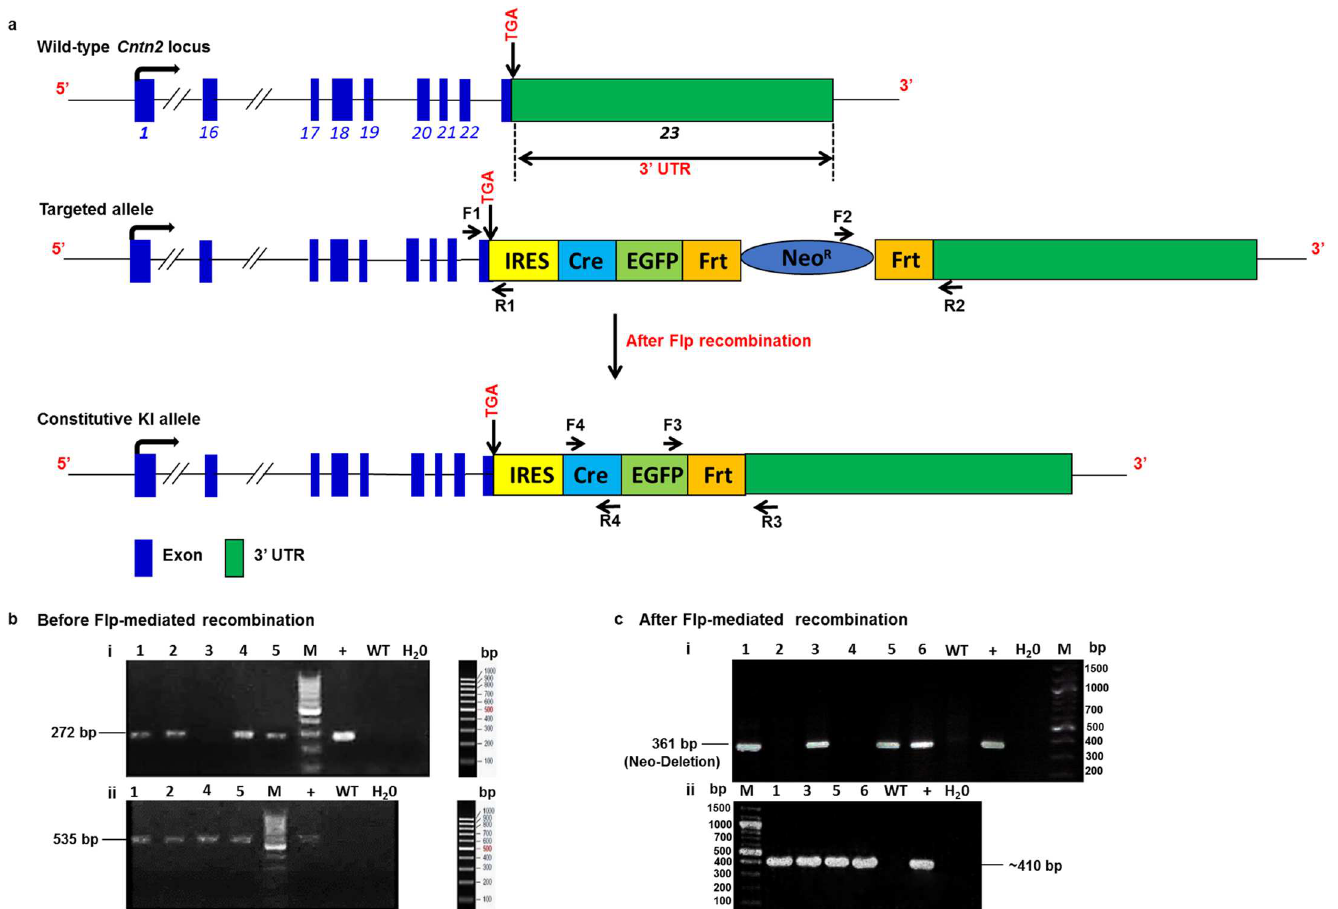
Fig 1. Genomic architecture of the Cntn2 3’UTR-IRES-Cre-EGFP/+ allele. a) Schematic of the endogenous Contactin-2 (Cntn2) locus comprising23 exons as indicatedby blue numbered blocks. Green block denotes the 3’UTR of the Cntn2 gene locatedin exon 23. The black right-handed arrow indicatesthe Cntn2 transcriptional start site driven by endogenous regulatoryelements. The IRES-Cre-EGFP-FRT-neo-PGK-FRT KI cassette was targeted to the 3’ UTR of the Cntn2 locus to ensure unperturbed bi-cistronic expressionof endogenousCntn2 protein and a Cre-EGFP fusion protein under the control of the endogenous regulatoryelementsuponFLP recombination. b) PCR genotypingof mice before FLP-mediated recombination using the indicatedprimer sets to amplify the 5’ (i) and 3’ (ii) insertion sites. In this example,4 out of 5 pups were positive by F1-R1 genotyping, and these 4 were subjectedto the second round of genotyping using F2-R2 primer sets. C) PCR genotypingof mice after FLP-mediated recombination using the indicatedprimer sets to amplify across the deleted Neo R cassette (i) and the Cre coding sequence(ii). In this example,4 out of 6 pups were positive by F3-R3 genotyping, and these 4 were subjectedto the second round of genotypingusing F4-R4 primer sets.